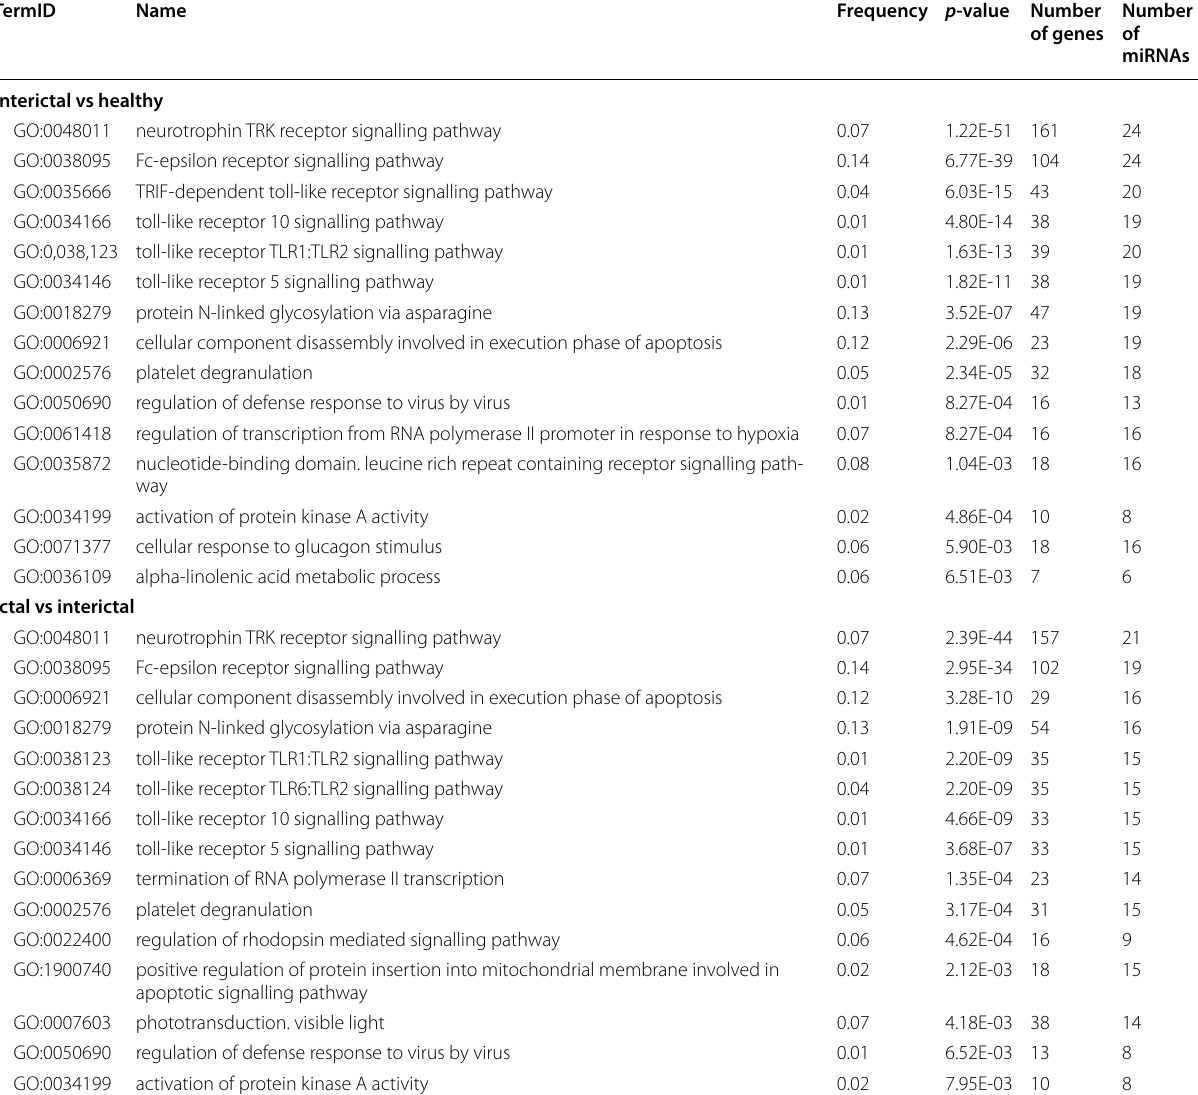
Number of genes of miRNAs